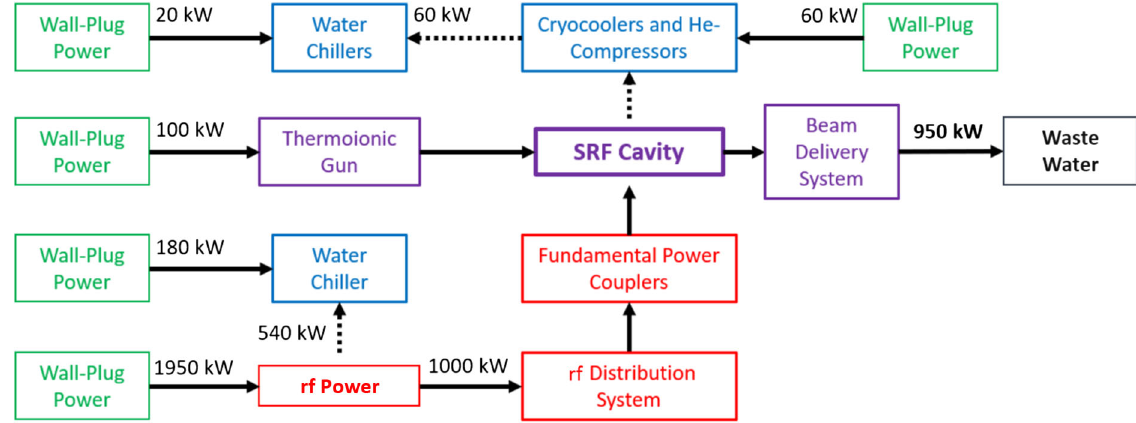
FIG. 27. Power flow diagram for the 10 MeV, 1 MW SRF accelerator.